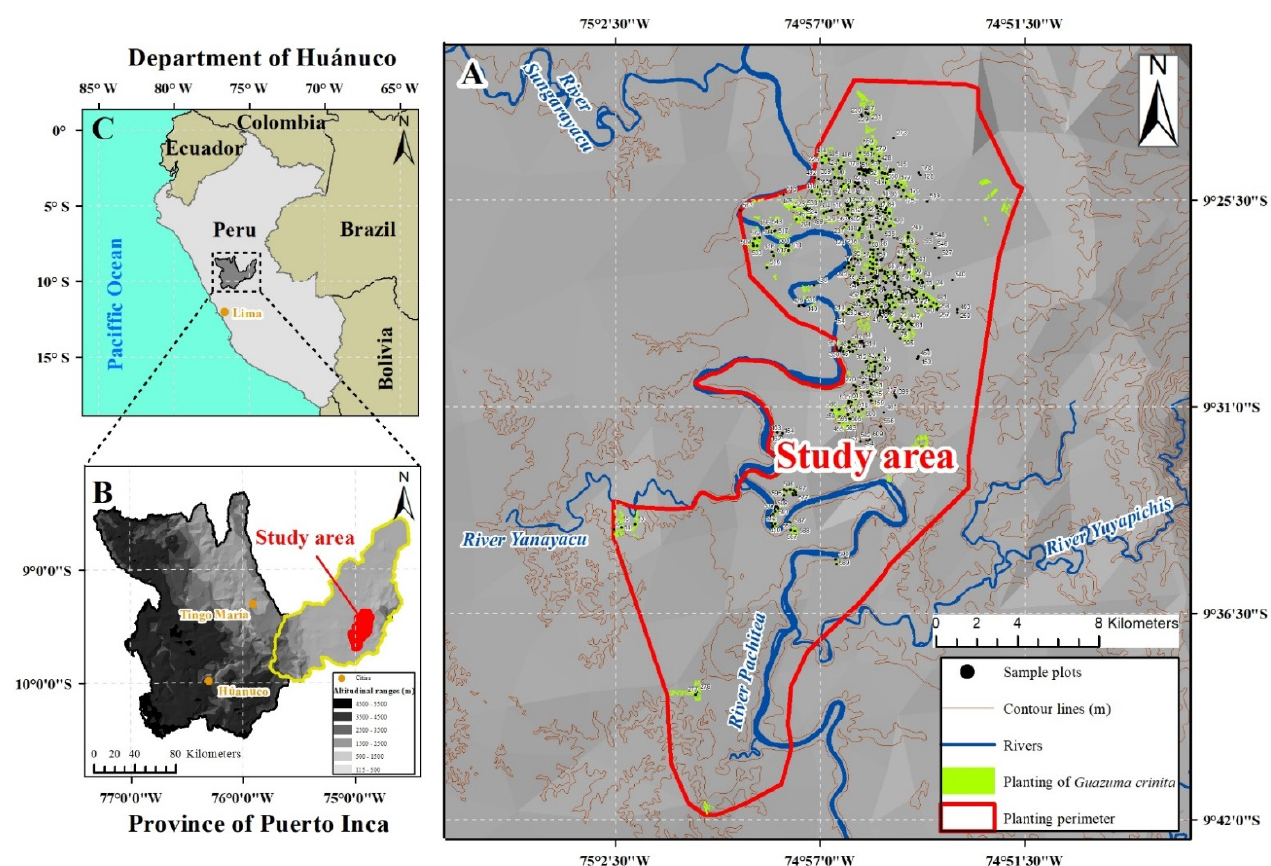
Figure 1. Location of the study and the forest plantations area of Guazuma crinita Mart. ( A ) in the Province of Puerto Inca ( B ), Department of Huánuco ( C ), Peruvian Amazon. Table 1. Descriptive statistics of the dendrometric and agroclimatic variables of the Guazuma crinita Mart. in the Peruvian